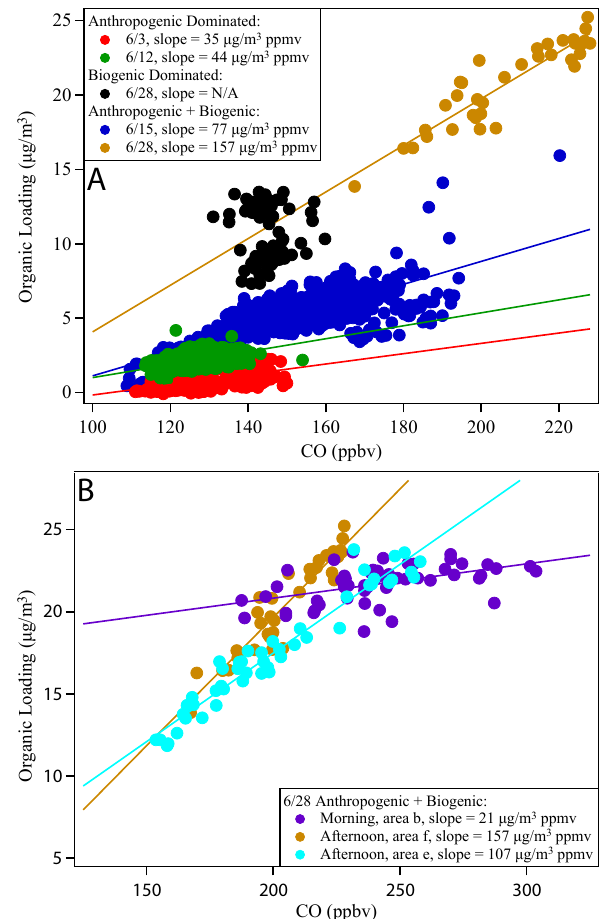
Fig. 11. Organic loading plotted against the CO concentration for CARES data according to the predominant emission sources influ- encing the airmass. The slope of these plots ( 1 OA/ 1 CO) gives a measure of the SOA production efficiency. All data in (A) are from the afternoon G-1 flights. A linear fit through the biogenic domi- nated 28 June data yielded a small, negative slope and is not shown for clarity. (B) Illustrates the evolution of 1 OA/ 1 CO in the mixed anthropogenic/biogenic plume on 28 June for the morning data (la- beled b in Figs. 3 and 4), the afternoon at the leading edge of the plume (labeled f in Figs. 3 and 4) where biogenic concentrations averaged 3.75ppbv in the afternoon, and at the trailing edge of the plume (labeled e in Figs. 3 and 4) where biogenic concentrations averaged 1.95ppbv in the